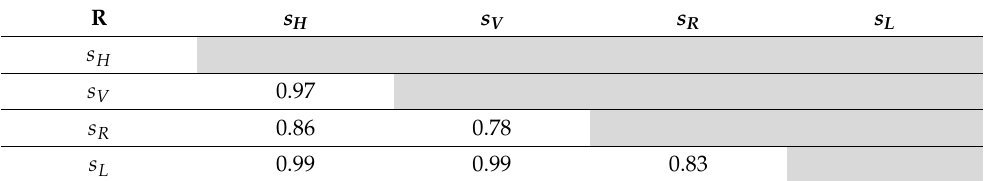
Table 5. Pearson Correlation (R) between GO modeled surface slope rms ( s ) using different polarizations. R s H s V s R s L s